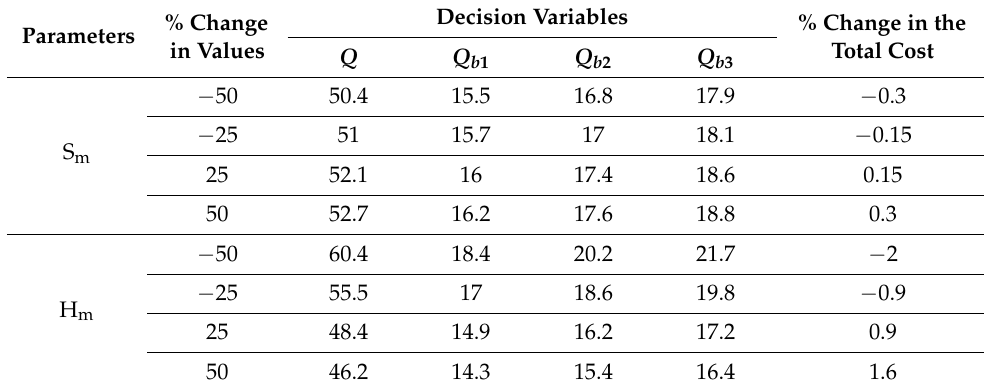
Table 8. Sensitivity analysis of manufacturer